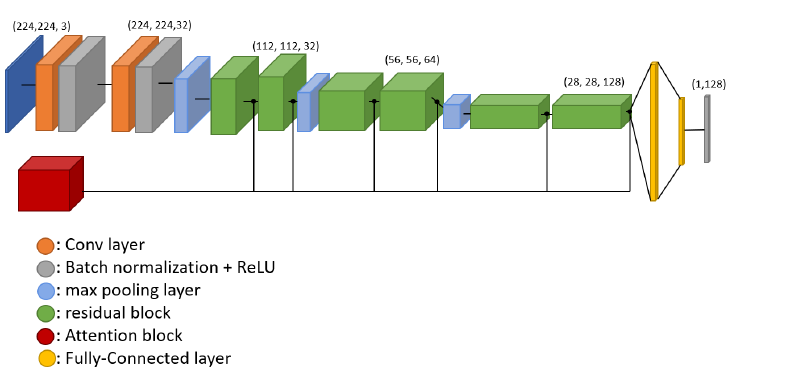
Figure 6. Network architecture of proposed embedding network.